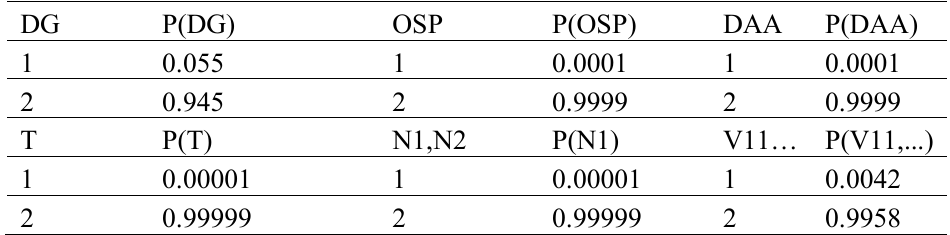
Table 7. Probabilities for events with two states